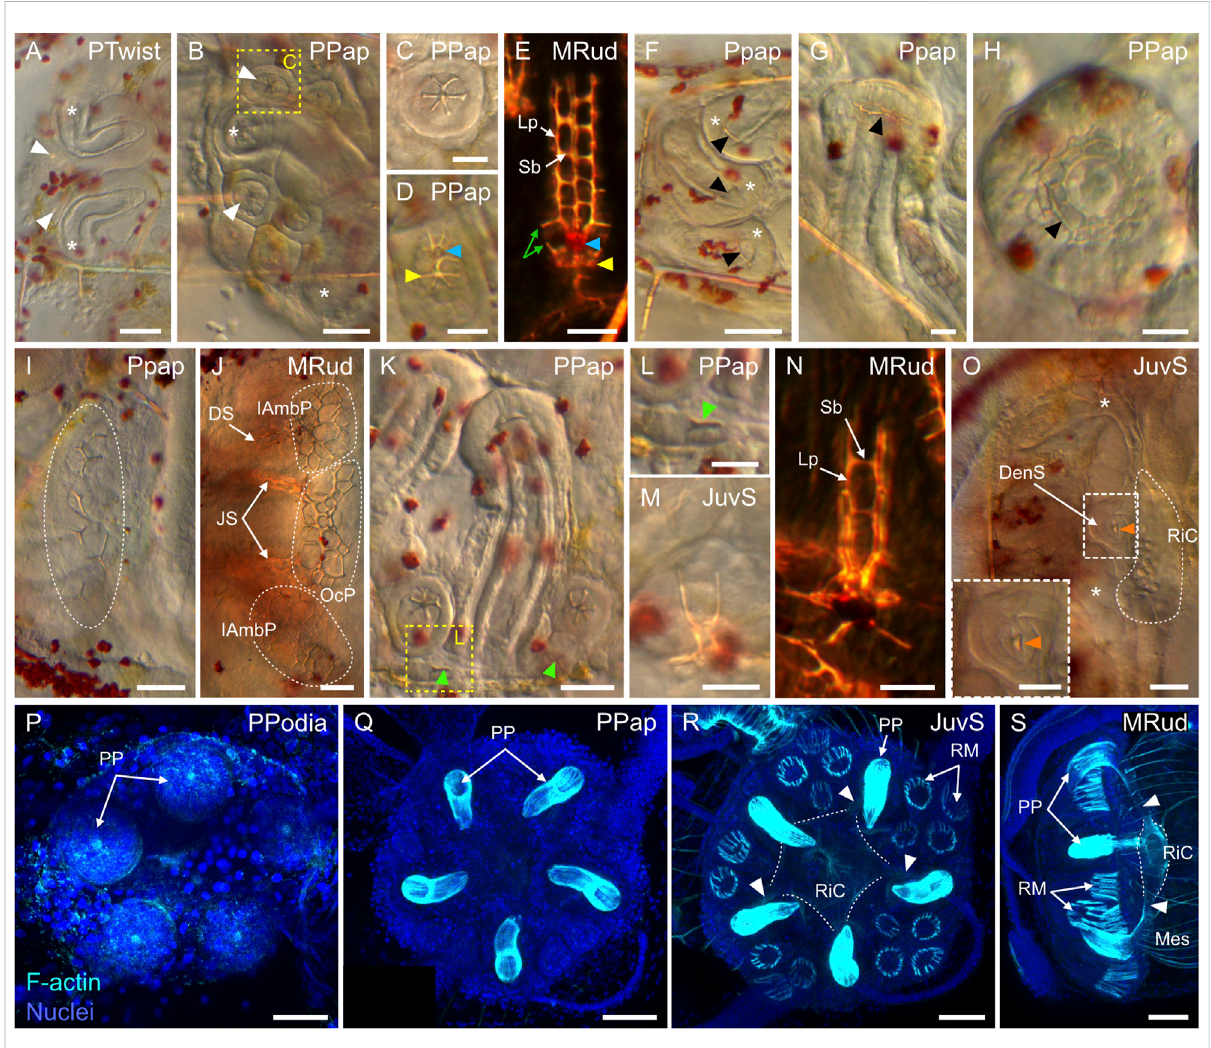
FIGURE 13 Skeletogenesis and myogenesis in the Paracentrotus lividus adult rudiment. Developmental stages are as follows: (A) primary podia twisting stage (PTwist); (B – D,F – I,K,L,Q) primary podia papilla stage (PPap); (E,J,N,S) mature rudiment stage (MRud); (M,O,R) juvenile spine stage (JuvS); (P) primary podia stage (PPodia). In (A – D,F – M,O) , images were acquired using bright- fi eld light microscopy. In (E,N) , images were obtained using polarized light. In (P – S) , images are maximum intensity projections of confocal z-stacks of larvae co-labeled for F-actin (muscles; cyan) and DNA (nuclei; blue),and they correspond to projections ofthe entire rudiment. (A – E) Close-ups of theskeletal elementassociated with thede fi nitive spines in top, oral view in (A – D) and in lateral view in (E) . (C) Close-up of the region outlined by the yellow box in (B) . (F – H) Close-ups of primary podia, in lateral view in (F,G) and in papilla view in (H) . (I,J) Close-up of the anlage of the future adult skeletal shell at the surface of the developing adult rudiment, which is in side view. (K – N) Close-up of the skeletal element associated with the juvenile spines in top, oral view in (K – M) and in lateral view in (N) . (L) Close-up of the region highlighted by the yellow box in (K) . (O) Close-up of the ring canal and of a dental sac in an adult rudiment inside view. ( (O) inset) Close-up of thedental sac. (P – S) Close-ups of thedeveloping adultrudimentin oral, deep view in (P – R) and inside view in (S) . In (A,B) , white arrowheads highlight the developing skeletal spicules of de fi nitive spines. In (A,B,F,O) , white asterisks mark the primary podia. In (D,E) , the yellow arrowhead indicates the hexaradiate spicule of a de fi nitive spine, and the blue arrowhead marks the hexagonal ring. In (E) , green arrows highlight additional skeletal branches emerging from either the hexaradiate spicule or the hexagonal ring. In (F – H) , black arrowheads highlight developing primary podia skeletal disks. In (I,J) , white dotted lines delineate the anlage of the future adult skeletal shell in (I) , and the developing ocular and interambulacral plates in (J) . In (K,L) , green arrowheads mark the developing triradiate spicules of juvenile spines. In ( (O) , (O) inset), orange arrowheads highlight a primordium of a developing tooth located within a dental sac. In (O,R,S) , white dotted lines outline the ring canal.In (R,S) ,whitearrowheadsmarkthemusclesassociatedwiththeradialcanals.Scalebar: (A,B,F) 50 μ m; (C,D,L,M) 12.5 µm; (E,K,N,P – S) 25 μ m; (G,H) 20 μ m; (I,J,O) 15 μ m;( (O) inset)7.5 µm.DenS:dentalsac;DS:de fi nitivespine;IAmbP:interambulacralplate;JS:juvenilespine;Lp:longitudinal processes; Mes: mesentery; OcP: ocular plate; PP: primary podium; RiC: ring canal; RM: ring muscle; Sb: stereomic